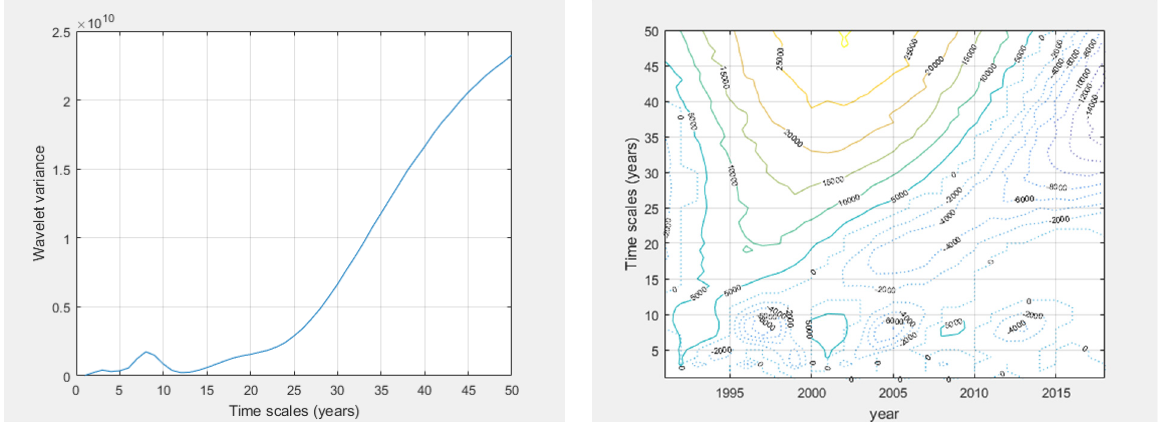
Figure 7. Wavelet square difference map and the real part of the contour map of the crop disaster area from 1991 to 2018.